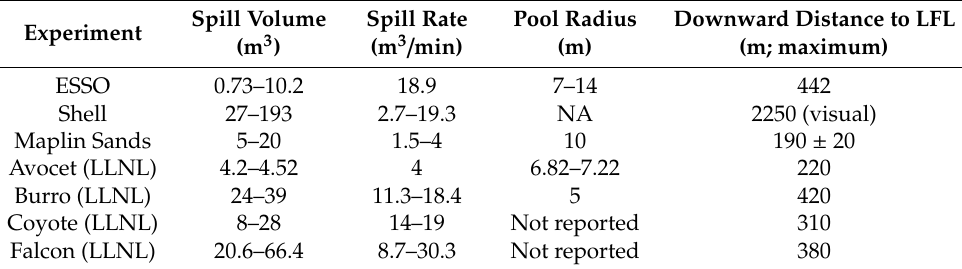
Table 5. LNG dispersion test on water